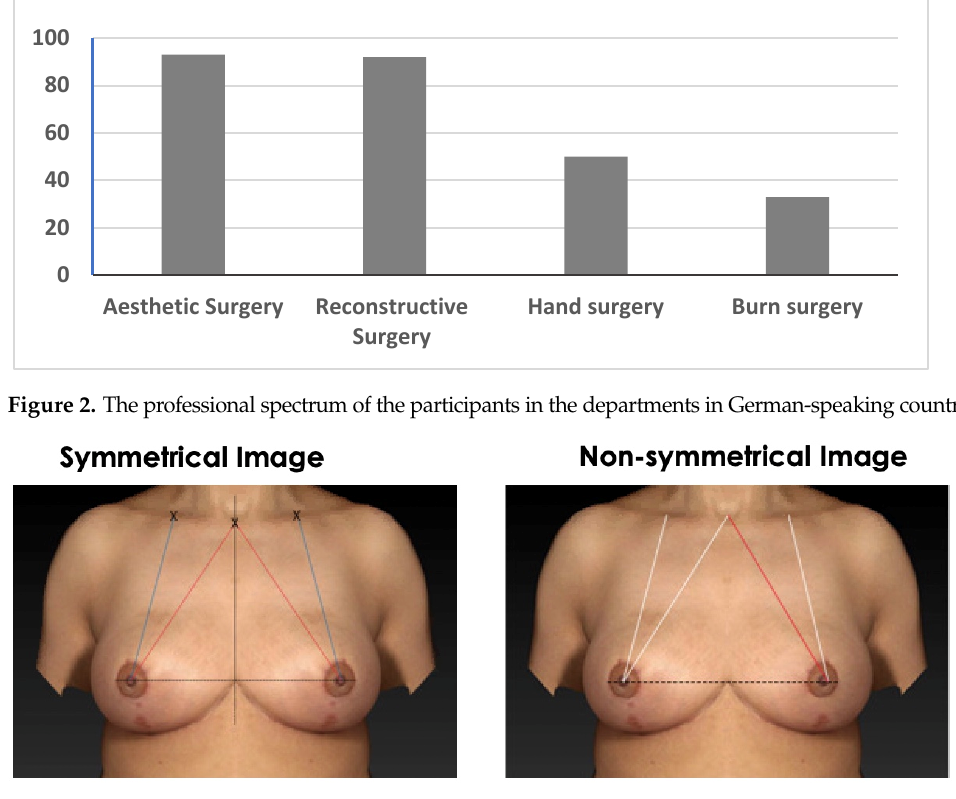
Figure 3. Symmetrical mirrored computer-simulated breast model and a non-symmetrical model (with a modified SSN-to-nipple distance). In total, 89% of the plastic surgeons and 81% of the patients find a symmetrical breast with mirrored position of the NAC more attractive than a non- symmetrical breast.